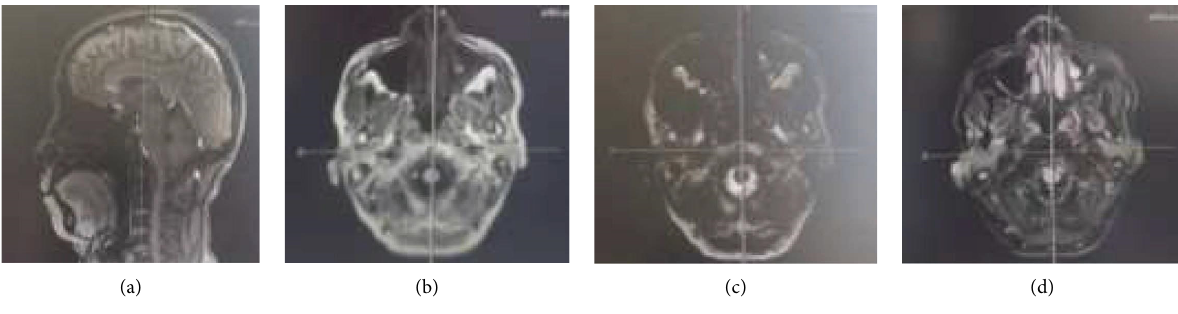
Figure 3: MRI image data of a patient. Female, 58 years old, high tinnitus in both ears without obvious inducement, followed by hearing loss, and gradually aggravated, with basic hearing loss in the recent six months, unstable walking, and tremor on both upper limbs. (a) MRI sagittal image; (b-c) T1 weighted image; and (d) T2 weighted